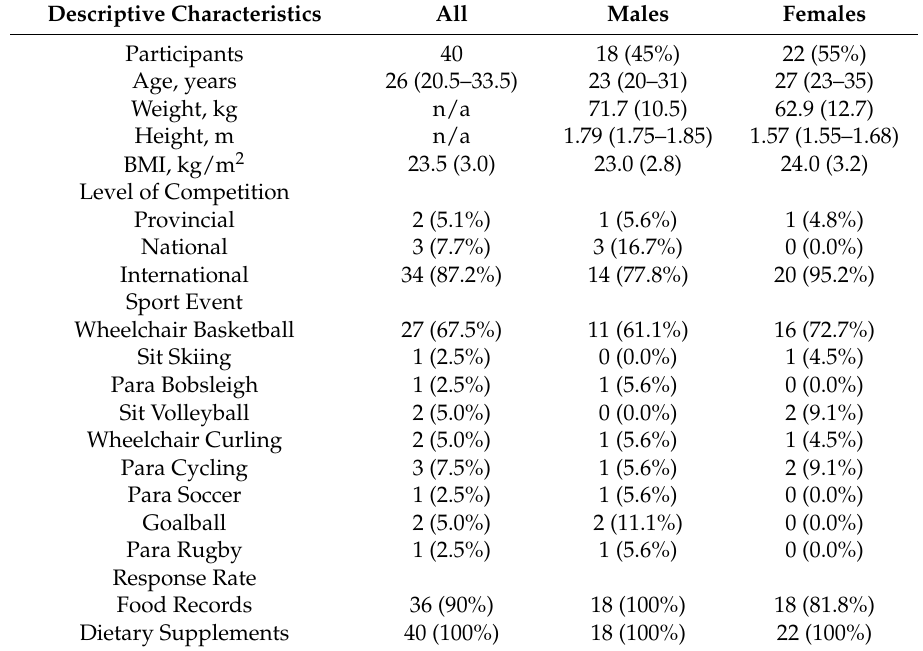
Table 1. Descriptive